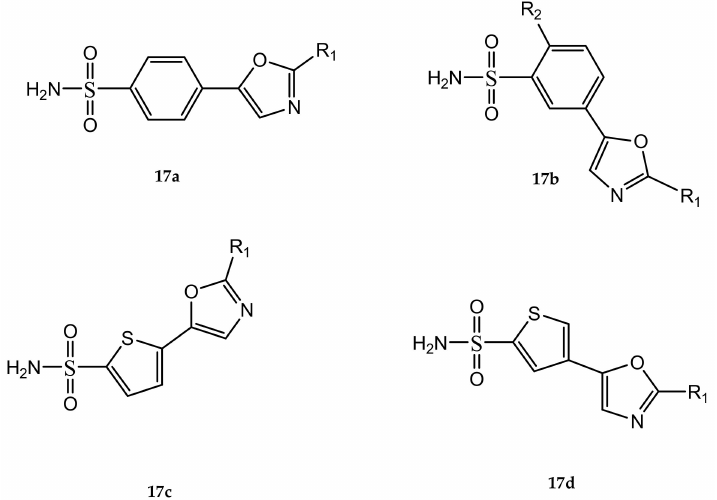
Figure 17. General structures of 5-(sulfamoyl)-aryl-1,3-oxazoles designed by Krasavin et al. [60] R 1 = alk, R 2 = alk.